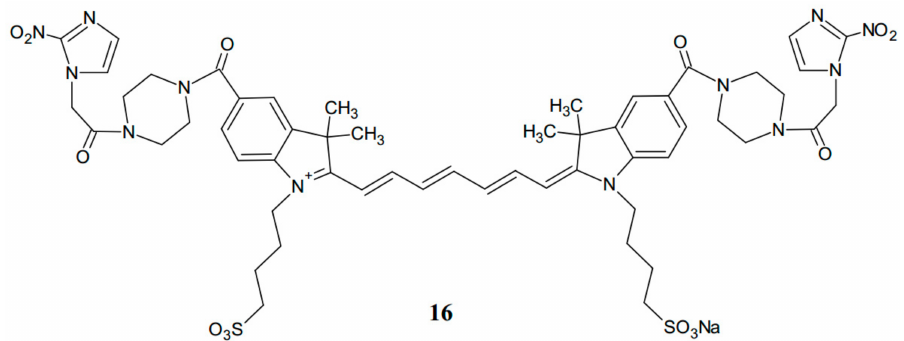
Figure 8. The structure of 2-nitroimidazole-ICG conjugate ( 16